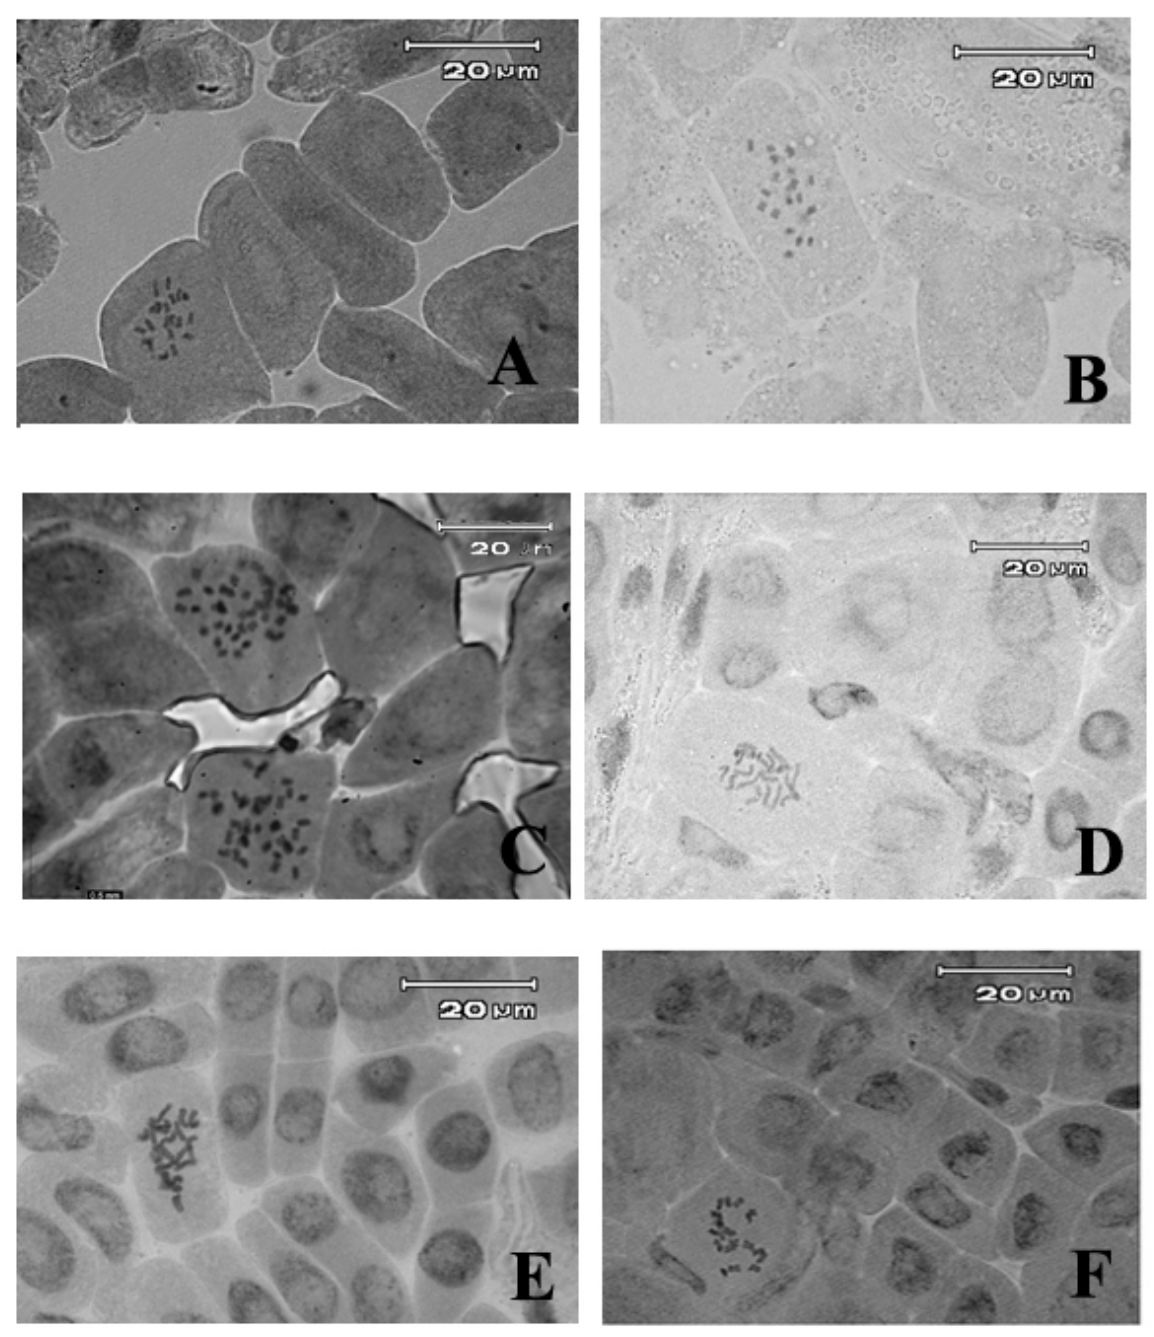
Fig. 1. Micrographs of chromosomes of root tips in studied Erodium species (A); E. neuradifolium (B); E. ciconium (C); E. cicutarium (D); E. malacoides (E); E. moschatum, E. oxyrrhynchum